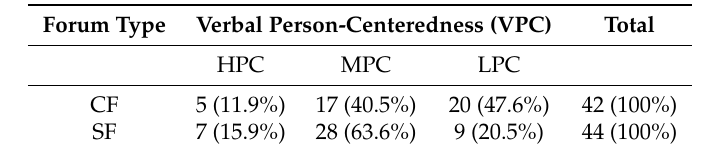
Table 7. Provision of emotional support and